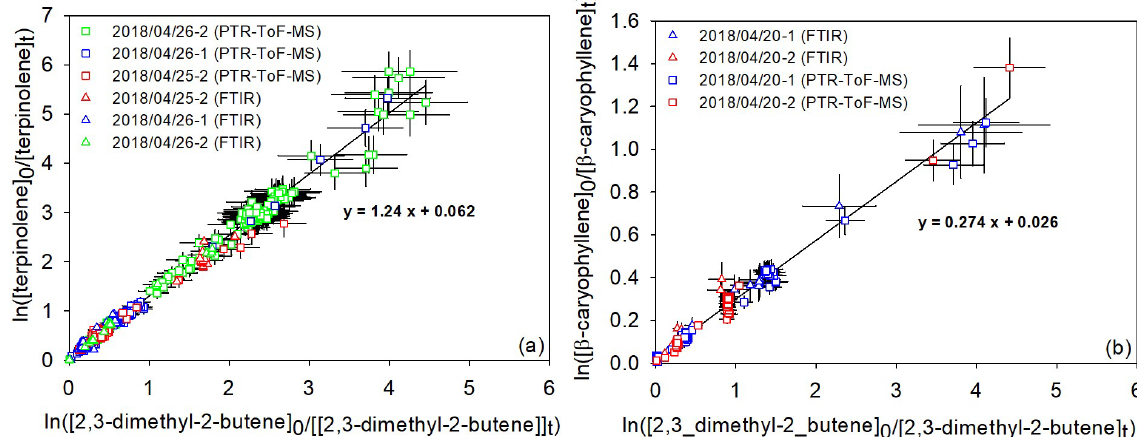
Figure 2. Relative kinetic plots measured by FTIR (triangle marks) and a PTR-ToF-MS (square marks) for terpinolene (a) and β -caryophyllene (b) .